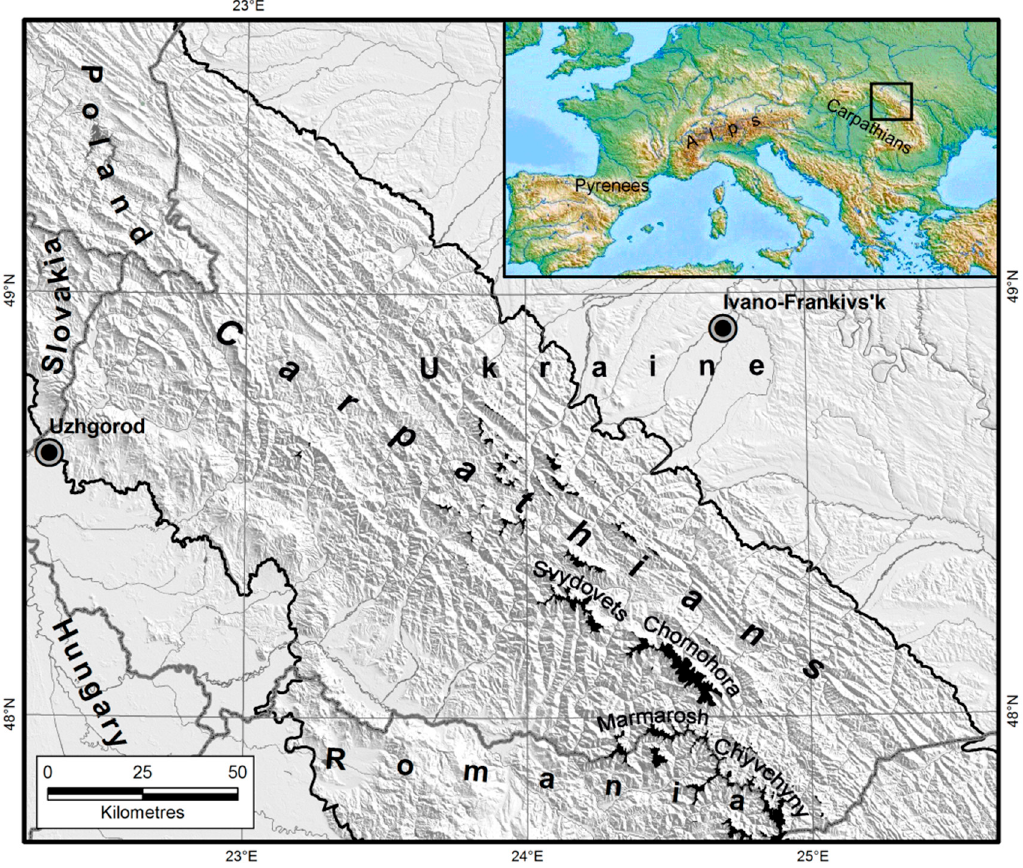
Figure 1. The Ukrainian Carpathians. Location of the high-mountain areas over 1500 m a.s.l. (black fill) within the Carpathians (thick black lines) and national borders (thick gray lines).